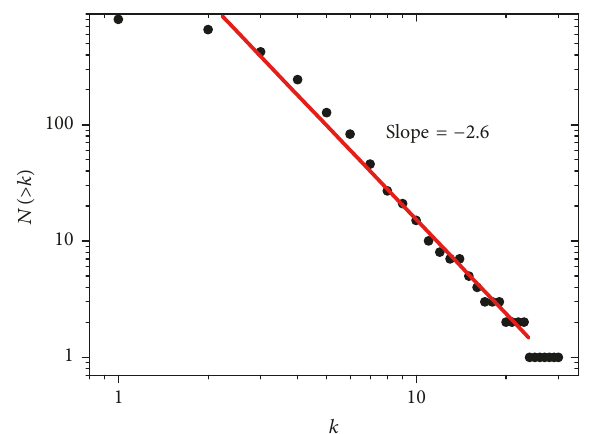
Figure 1: The degree follows (heavy tailed) power law distribution with slope = − 2.6 in our data.